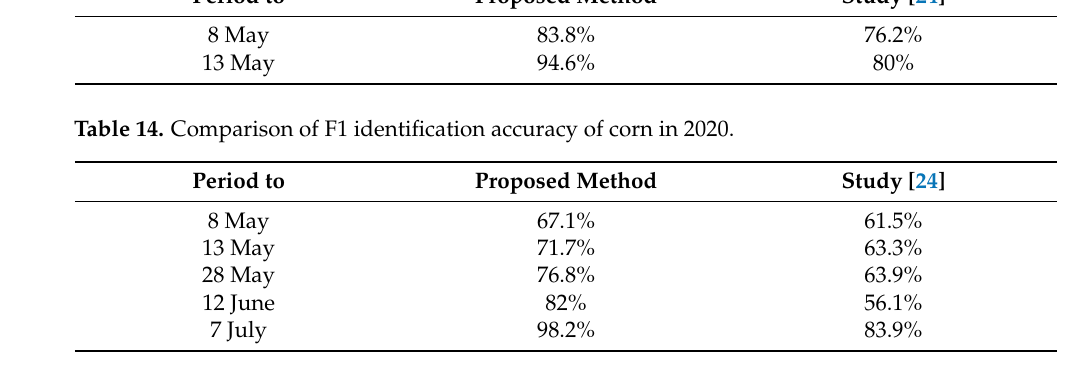
Table 15. Comparison of F1 identification accuracy of soybeans in 2020.